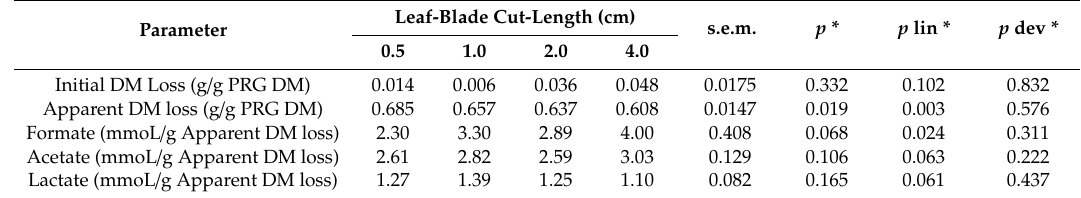
Table 2. E ff ect of fresh perennial ryegrass (PRG) leaf-blade cut-length on initial and apparent dry matter (DM) loss, and production of aqueous fermentation end-products by N. frontalis .